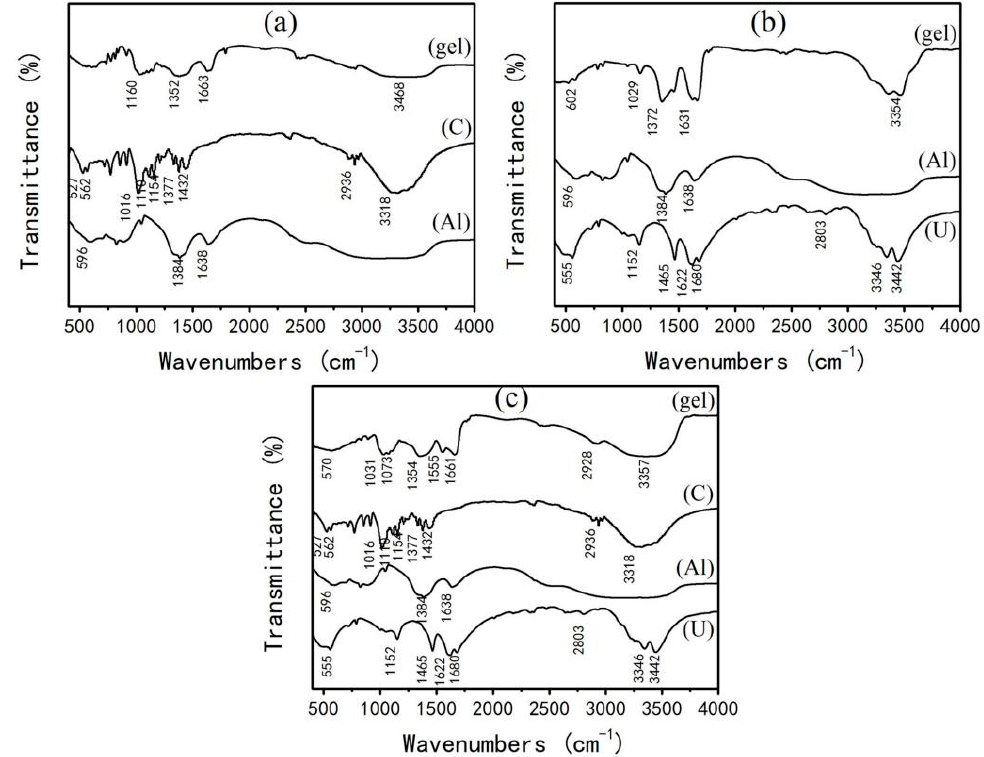
Figure 4. IR spectra of the gels and related materials: ( a ) gel of glucose and aluminum nitrate (C/Al = 8); ( b ) gel of urea and aluminum nitrate (U/Al = 1); ( c ) gel of urea, glucose, and aluminum nitrate (U/Al = 1, C/Al = 8) .